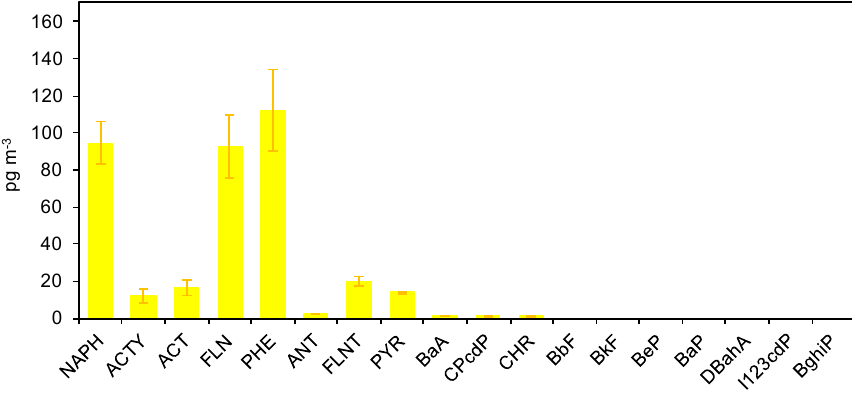
Figure 11. PAHs pattern in gas phase during AREX2011.